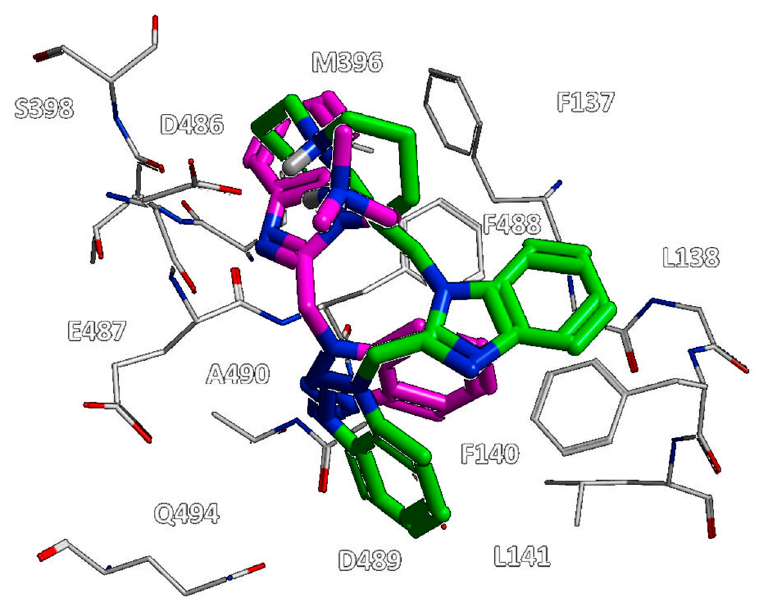
Figure 16. Molecular docking positioning observed for the compounds 114 (C atom; magenta) and 118 (C atom; green) at the RSV F protein surface (PDB code = 5KWW) [27]. The most relevant residues are shown and labelled.